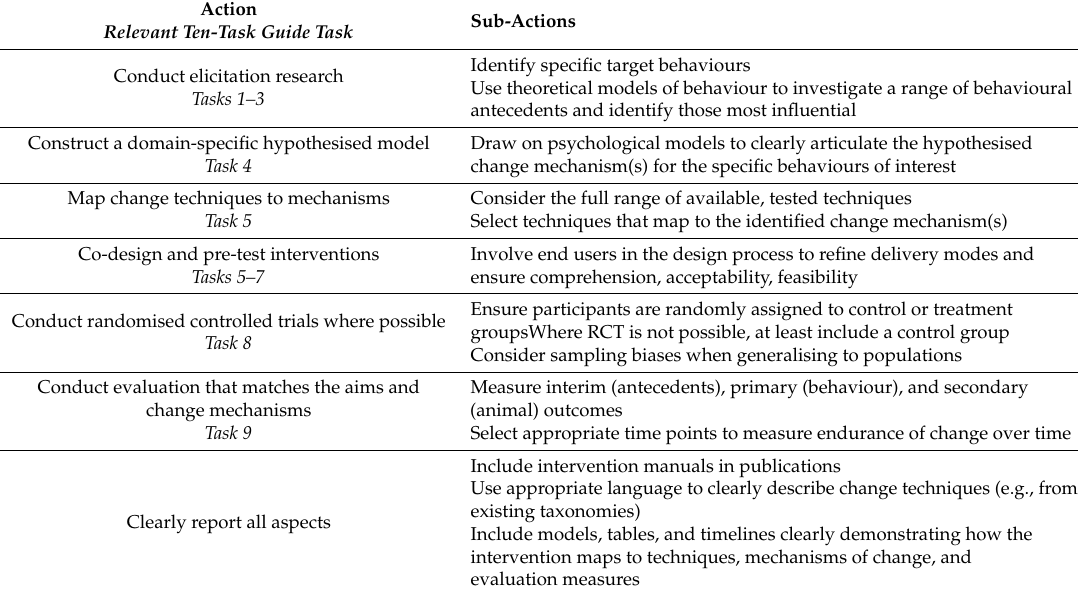
Table 3. Recommendations to improve research into behaviour change interventions in animal care and interactive settings.